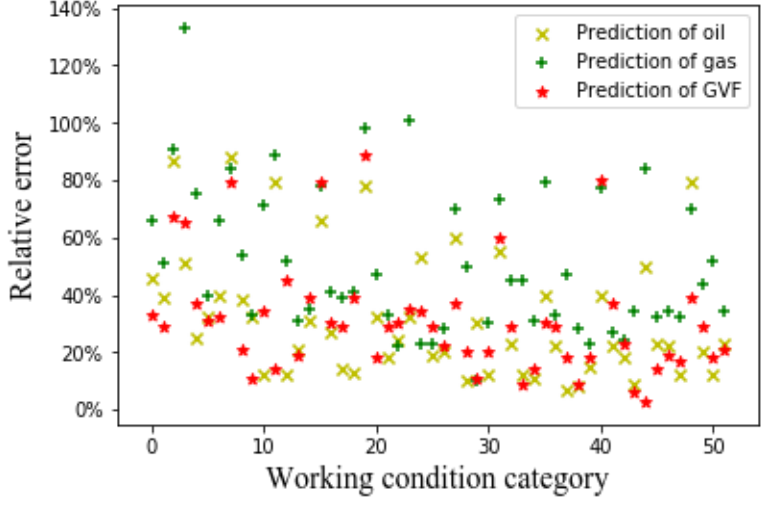
Figure 13. Relative error of CNN algorithm based on original capacitance value.